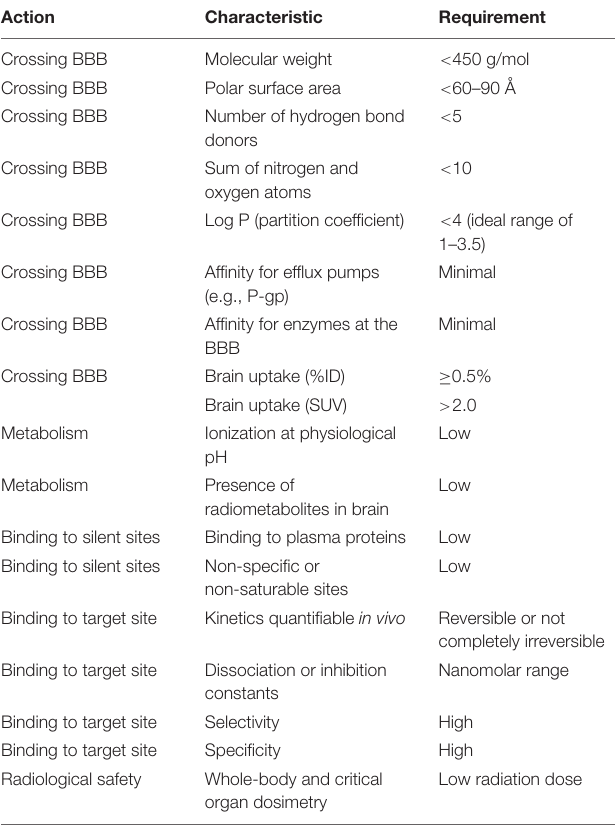
TABLE 2 | Criteria for passive diffusion of a radiotracer across the blood-brain-barrier (BBB) and good bioavailability (Lipinski et al., 2001;